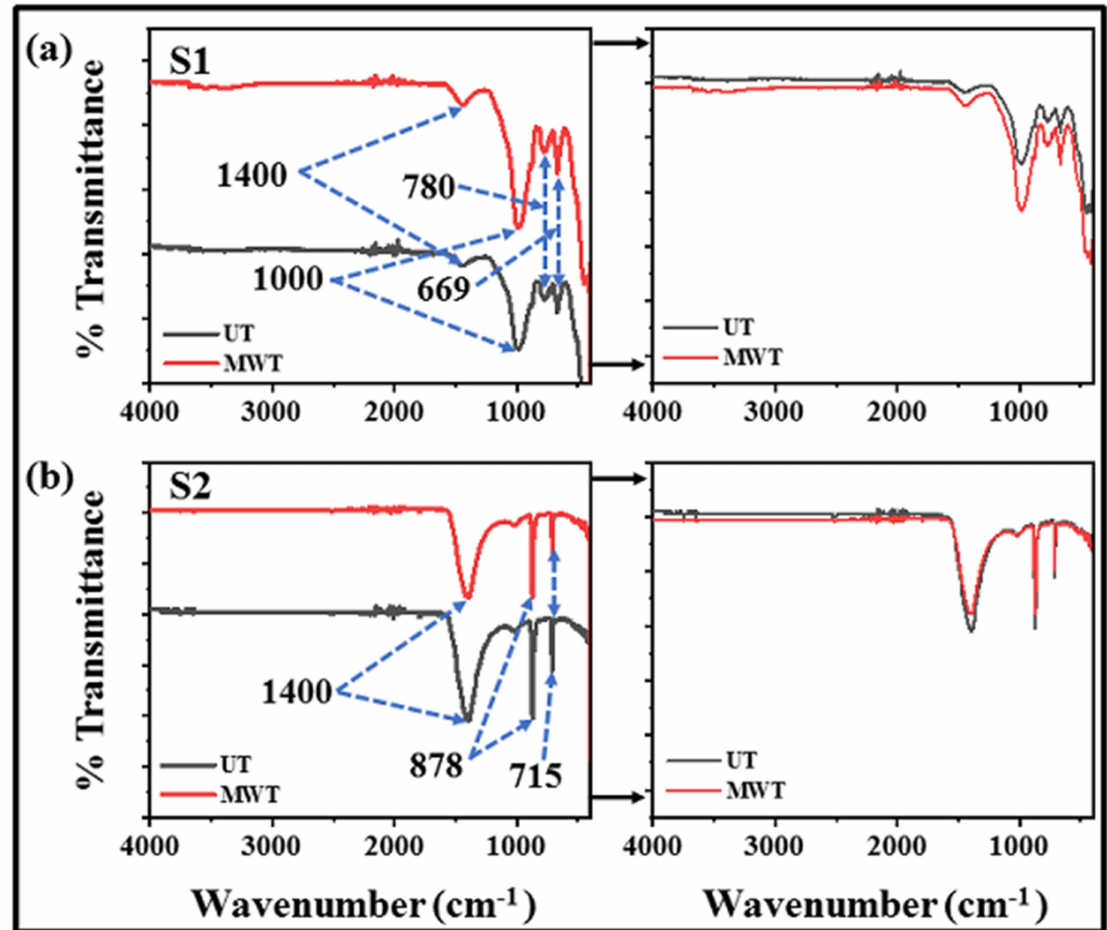
Figure 4. FTIR spectra of the untreated (UT) and microwave-treated (MWT) samples. ( a ) S1); ( b )